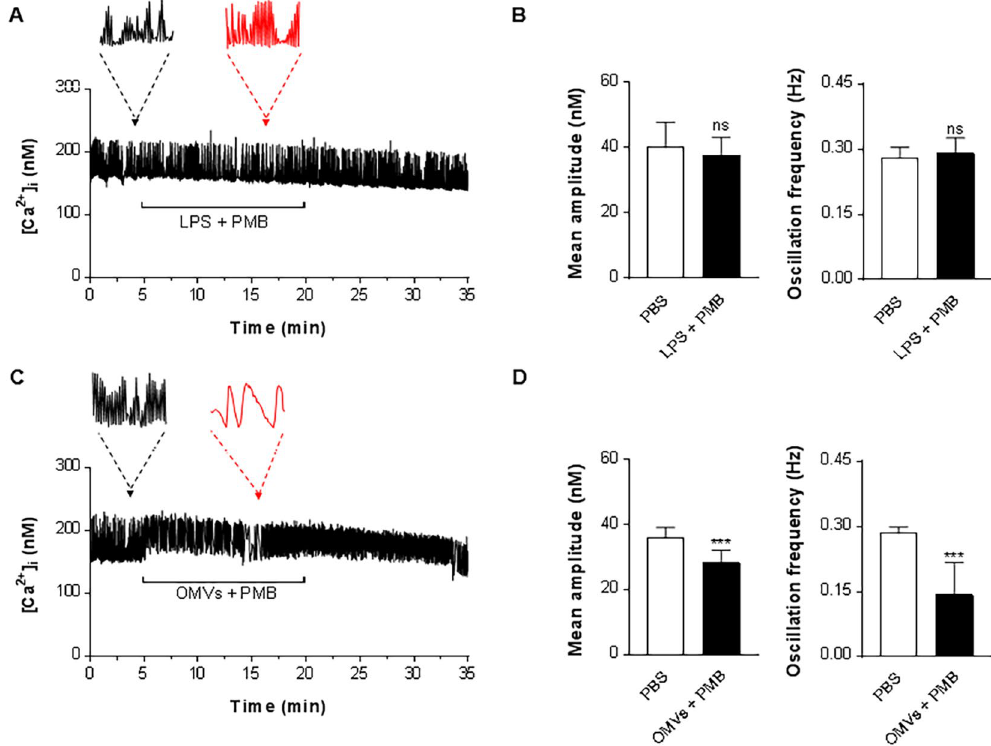
Figure 4. Both vesicular LPS and other components contribute to OMVs-induced contractility dysfunction. ( A and C ) LPS (5 µ g/mL) ( A ) or OMVs (1 μ g/mL) ( C ) were pre-incubated with polymycin B (PMB; 5 µ g/mL) for 10 min, where after cells were treated with the mixture by addition to the extracellular perfusion solution. Horizontal lines show application time of LPS + PMB or OMVs + PMB. Black and red arrows/dashed lines indicate the expanded traces acquired at a time point prior to (4 min) and following (16 min) infusion of LPS or OMVs. Traces show representative recordings s from four separate experiments in each group. ( B and D ) Mean amplitude and oscillation frequency of LPS- ( B ) and OMVs-treated cells ( D ) were quantified out of a total of 30 analyzed ROI from four separate experiments in each group. ** * P < 0.001; ns, not significant; versus PBS group. Error bars indicate